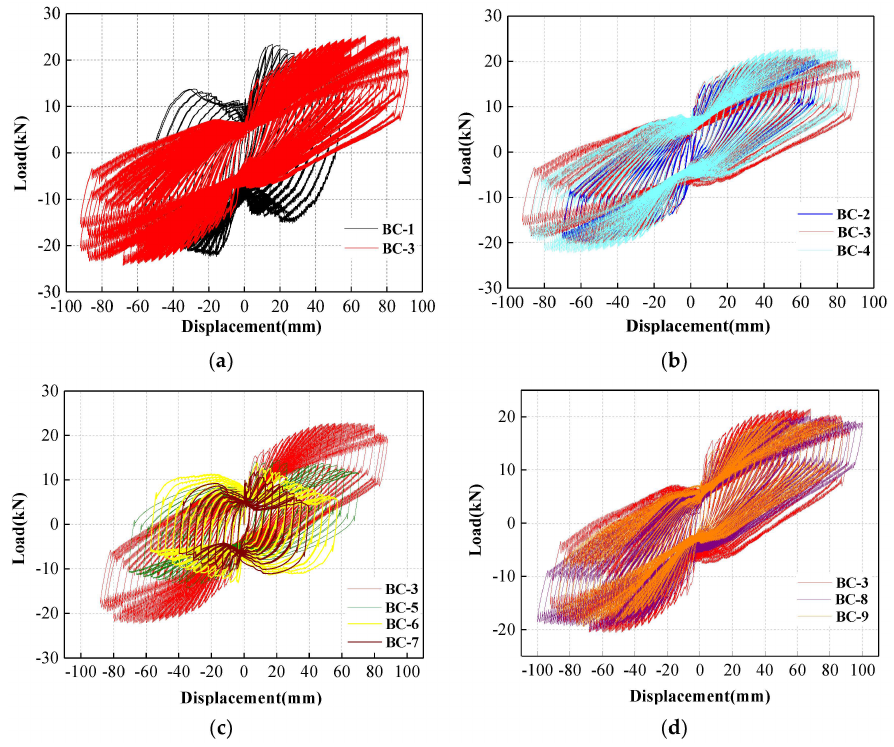
Figure 8. Hysteretic load–displacement loops. ( a ) RC vs. GFRP; ( b ) Stirrup ratio group; ( c ) Axial pressure ratio group; ( d ) Concrete strength